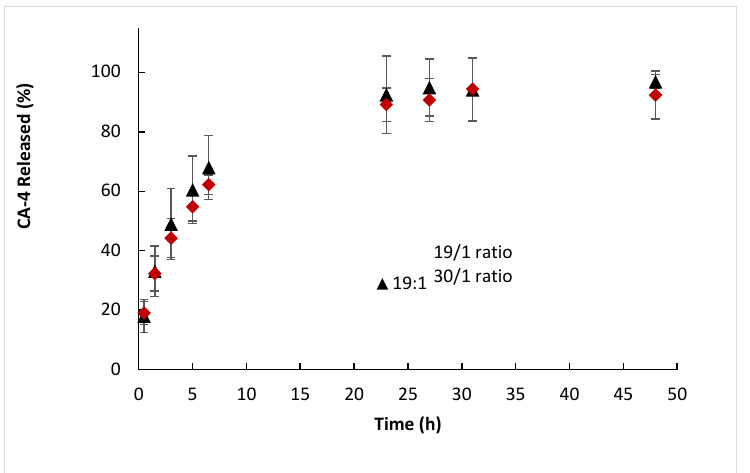
Figure 12. Release profiles of CA-4 from PEGMA- ran -FA, using different polymer/drug weight ratios, at 37 °C.